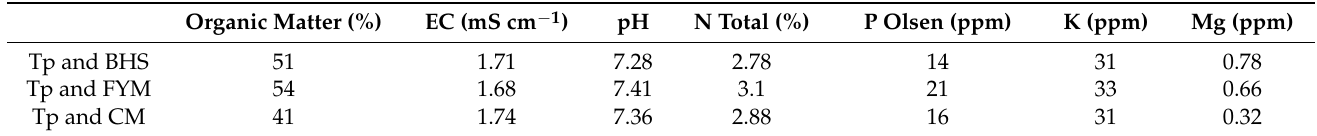
Table 1. Characteristics of tomato pomace composts used as soil